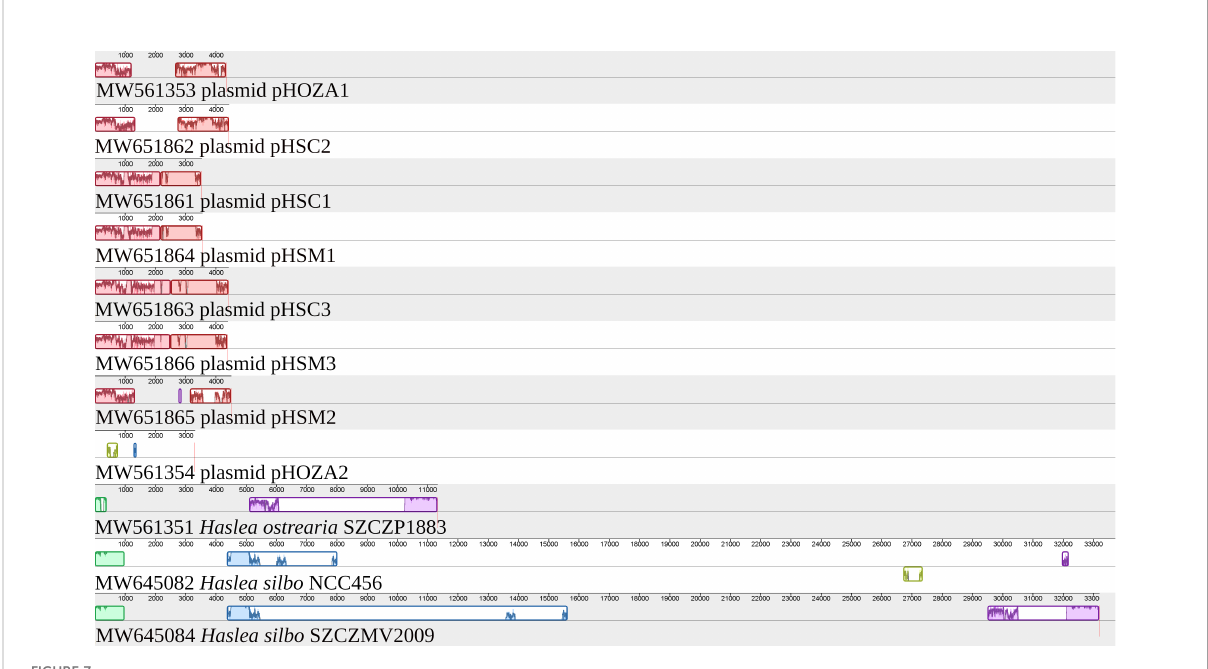
FIGURE 7 MAUVE alignment of the plasmids and plastomes of Haslea ostrearia SZCZP1883 and Haslea silbo. The alignment illustrates the conservation between some of the plasmids. It shows especially the conservation between the plasmid pHOZA1 from H. ostrearia SZCZP1883 and the plasmid pHSC2 from H. silbo